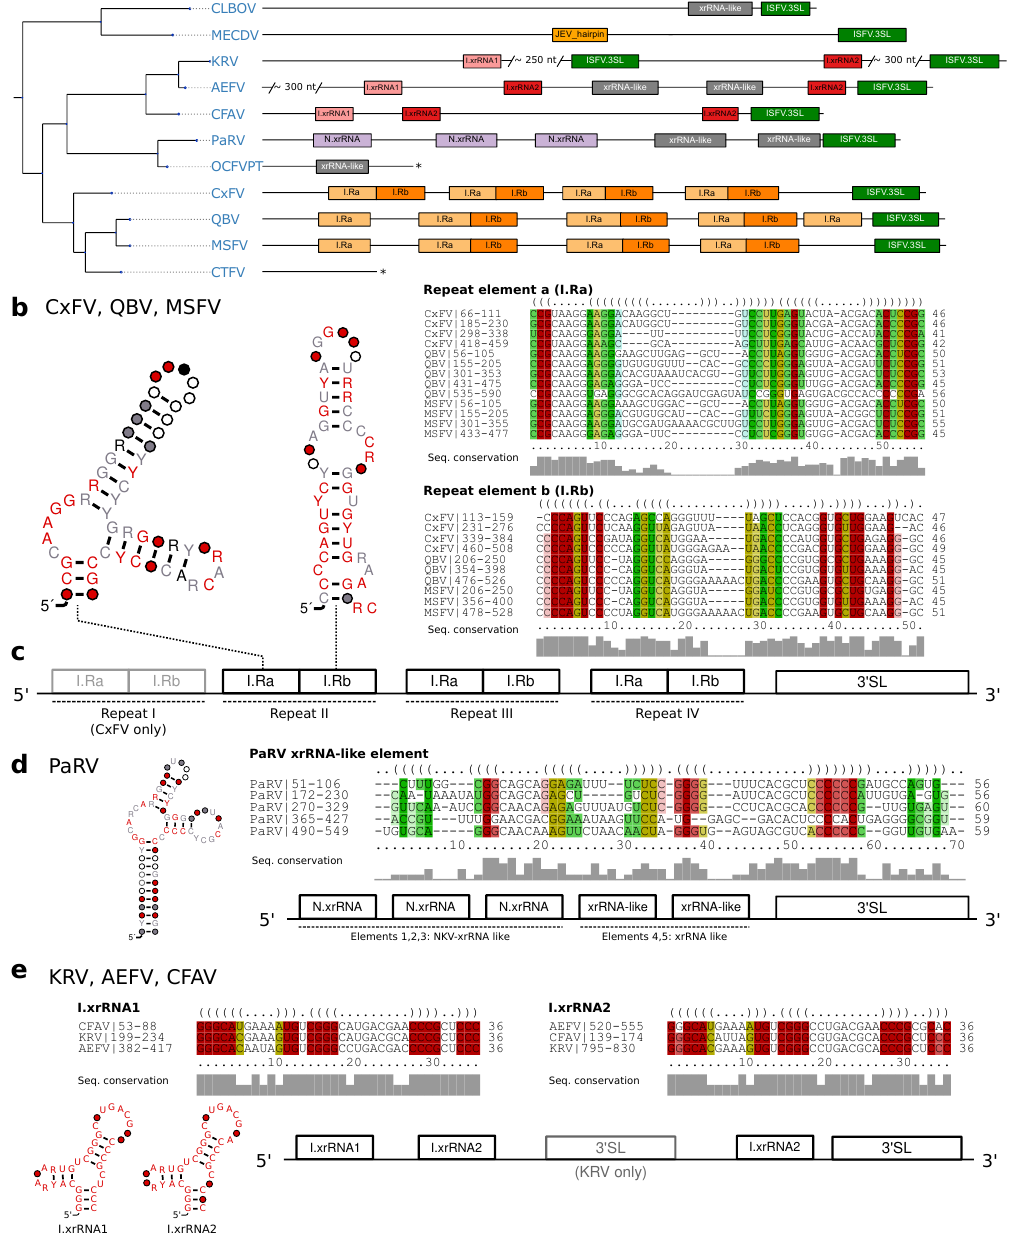
Figure 4. ( a ) Annotated Tree of cISFV 3 (cid:48) UTRs. Asterisks denote incomplete 3 (cid:48) UTR sequences. Species without available 3 (cid:48) UTR are not shown. ( b ) Consensus secondary structure plots and structural alignments of CM hits of Repeat a/b elements in CxFV, QBV, and MSFV. ( c ) Schematic of the common architecture of CxFV, QBV, and MSFV. Element I-IV refers to the respective repeat of elements. ( d ) Consensus structure plot and structural alignment of all CM hits of xrRNA-like elements in PaRV. ( e ) Proposed 3 (cid:48) UTR architecture of KRV, AEFV, and CFAV with consensus structure plots and structural alignments of I.xrRNA1 and